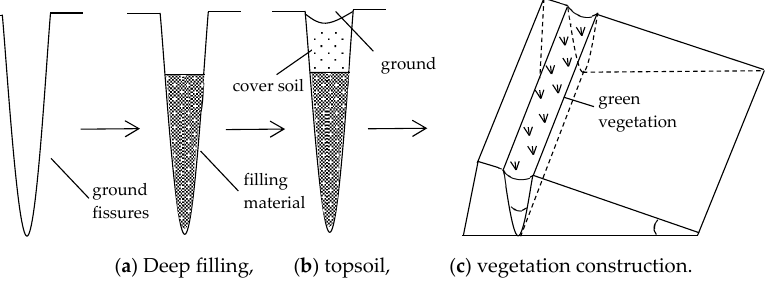
Figure 17. “Three–step method” for treating ground fissure.